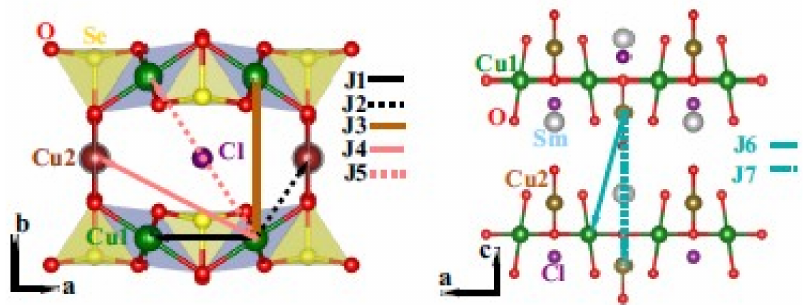
Figure 19. The exchange paths for various magnetic interactions in Cu 3 Sm(SeO 3 ) 2 O 2 Cl. Reprinted figure with permission from [34]. Copyright (2016) by the American Physical Society.